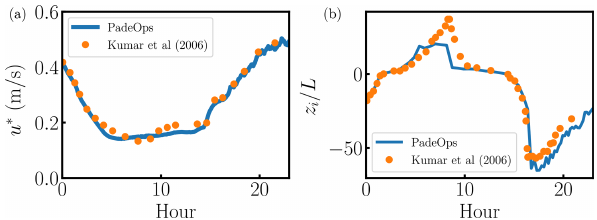
Figure C2. Diurnal cycle validation case (Kumar et al., 2006). (a) Diurnal cycle friction velocity u ∗ . (b) Diurnal cycle boundary layer height normalized by the Obukhov length z i /L . Details for boundary layer height estimation provided in Kumar et al. (2006).